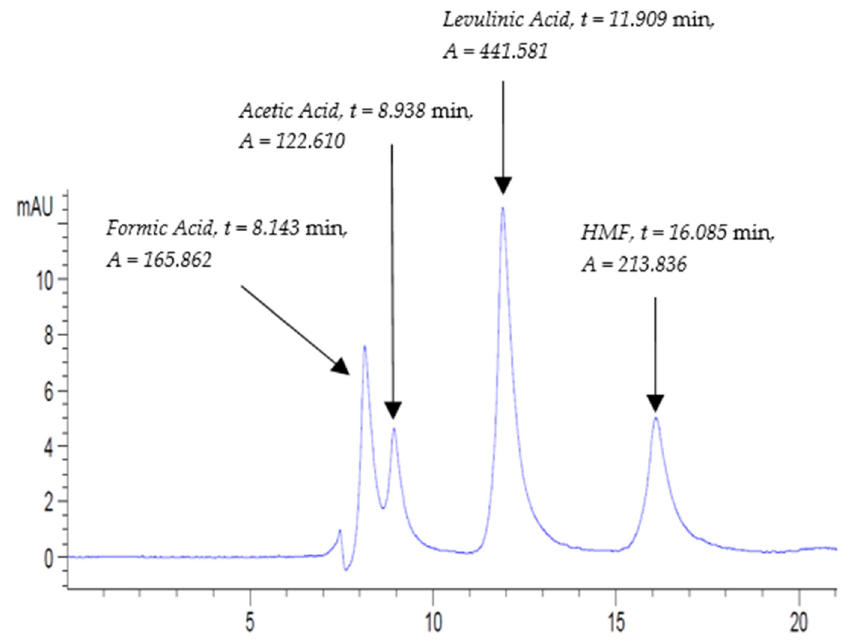
Figure 3. Mixed standard solution STD4-Inline-B.VIN (A) chromatogram at UV-210 nm at the following conditions: flow rate, 0.3 mL/min; column temperature, 30 °C; and run time, 20 min. The chromatogram of the balsamic vinegar sample B.VIN (A), executed at the same HPLC conditions, is shown in Figure 4. This chromatogram demonstrates four major peaks, where all of them eluted no later than 20 min. Using the elution order of analytes in the mixed standard solution STD4-Inline-B.VIN (A) displayed in Figure 3, the second peak, third peak, and fourth peak correspond to acetic acid, levulinic acid (IS), and HMF, respectively. The first peak was not relevant to any of the selected standards and was denoted as unknown. The chromatogram of the second sample of the duplicates of bal- samic vinegar B.VIN (B) is displayed in Figure S21.